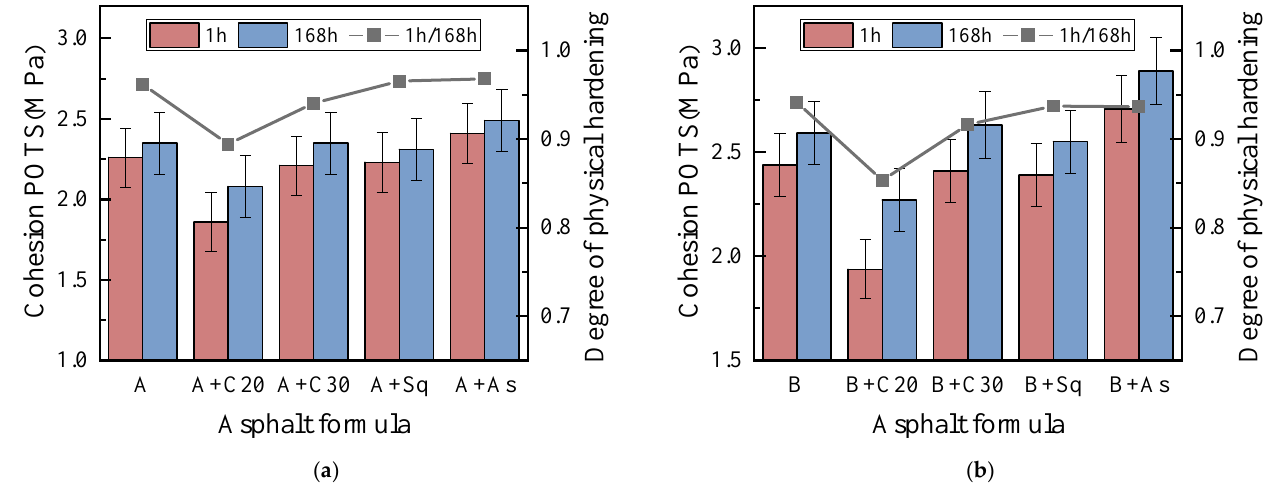
Figure 6. Cohesion POTS in dry conditions. ( a ) Asphalt A. ( b ) Asphalt B.